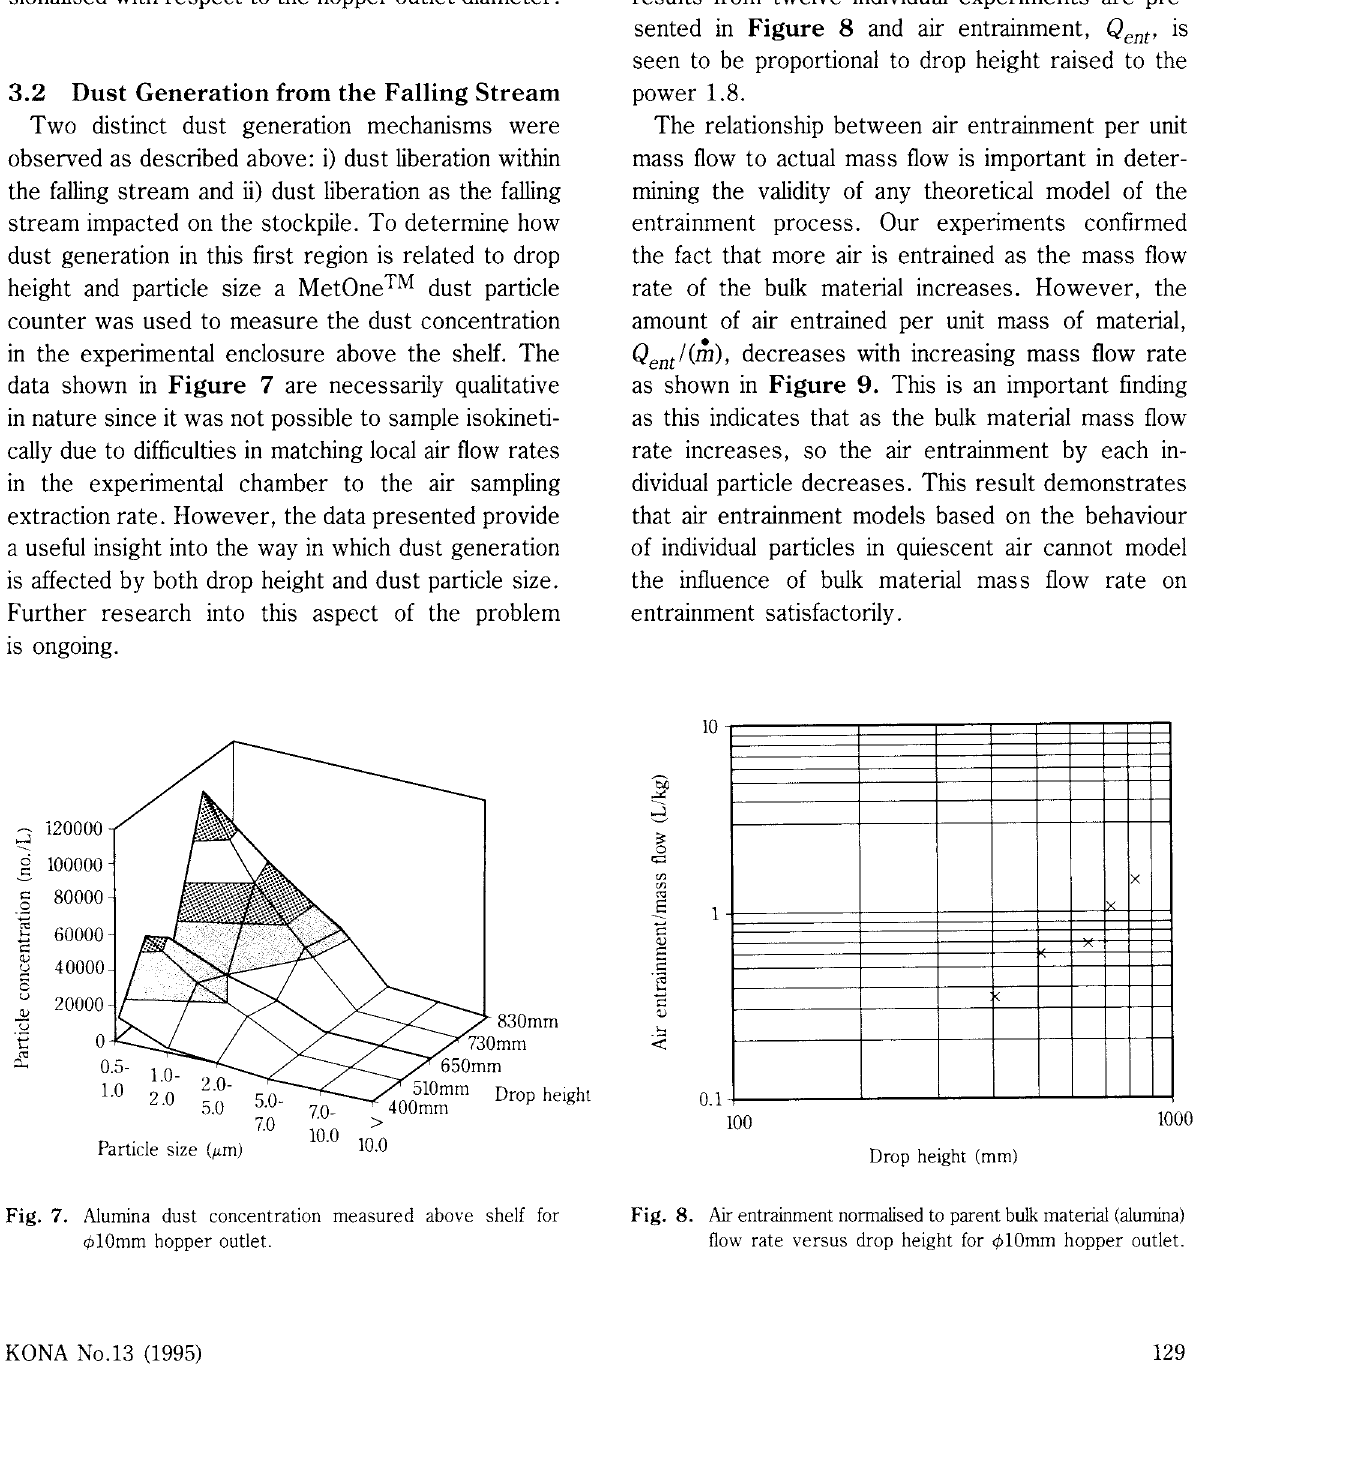
Fig. 8. Air entrainment normalised to parent bulk material (alumina) flow rate versus drop height for <t>lOmm hopper